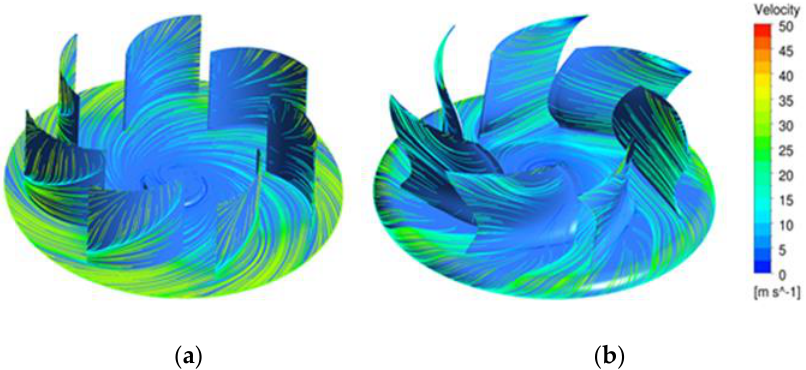
Figure 15. Velocity streamline on the surface (at 1100 rpm): (a) Original model, (b) Optimized model.